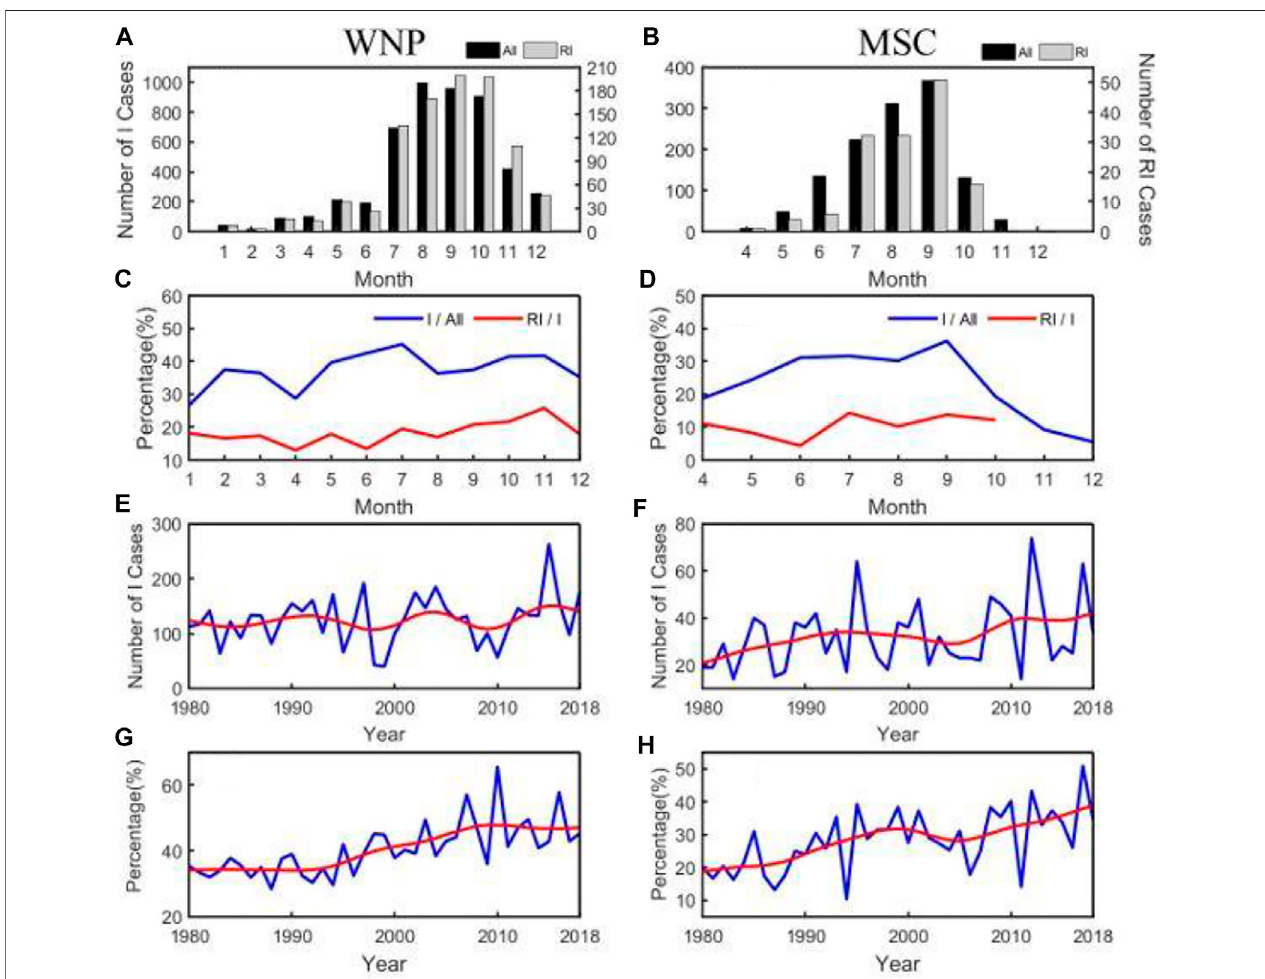
FIGURE 3 | The monthly frequencies of all intensi fi cation (black) and RI (gray) cases (A,B) and their proportions (%) to the frequency of all TC cases (blue) and all intensi fi cation (red) cases (C,D) , and the interannual variability of TC intensi fi cation frequency (blue) (E,F) and its proportions to the freuqency of all TC intensity changes (blue) (G,H) over the WNP (A,C,E,G) and the MSC (B,D,F,H) . E – H The red curves indicate after a 5-point smoothing.